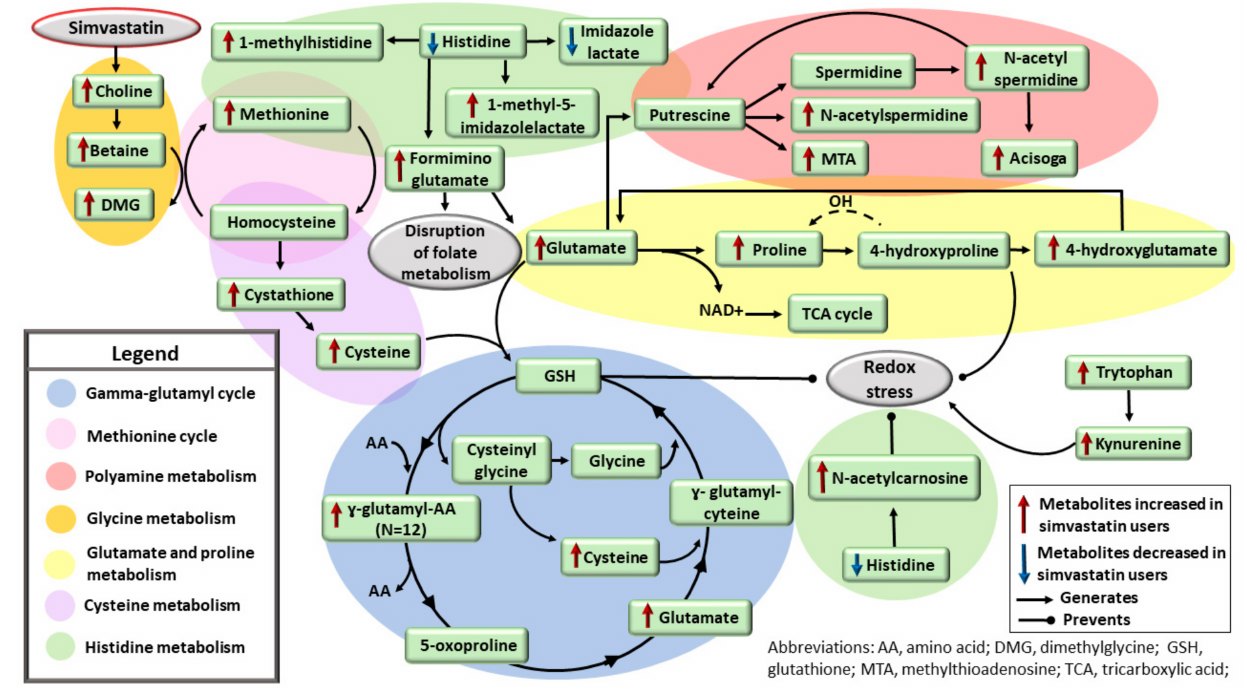
Figure 4. Effects of simvastatin treatment on amino acid and peptide pathways and redox balance.